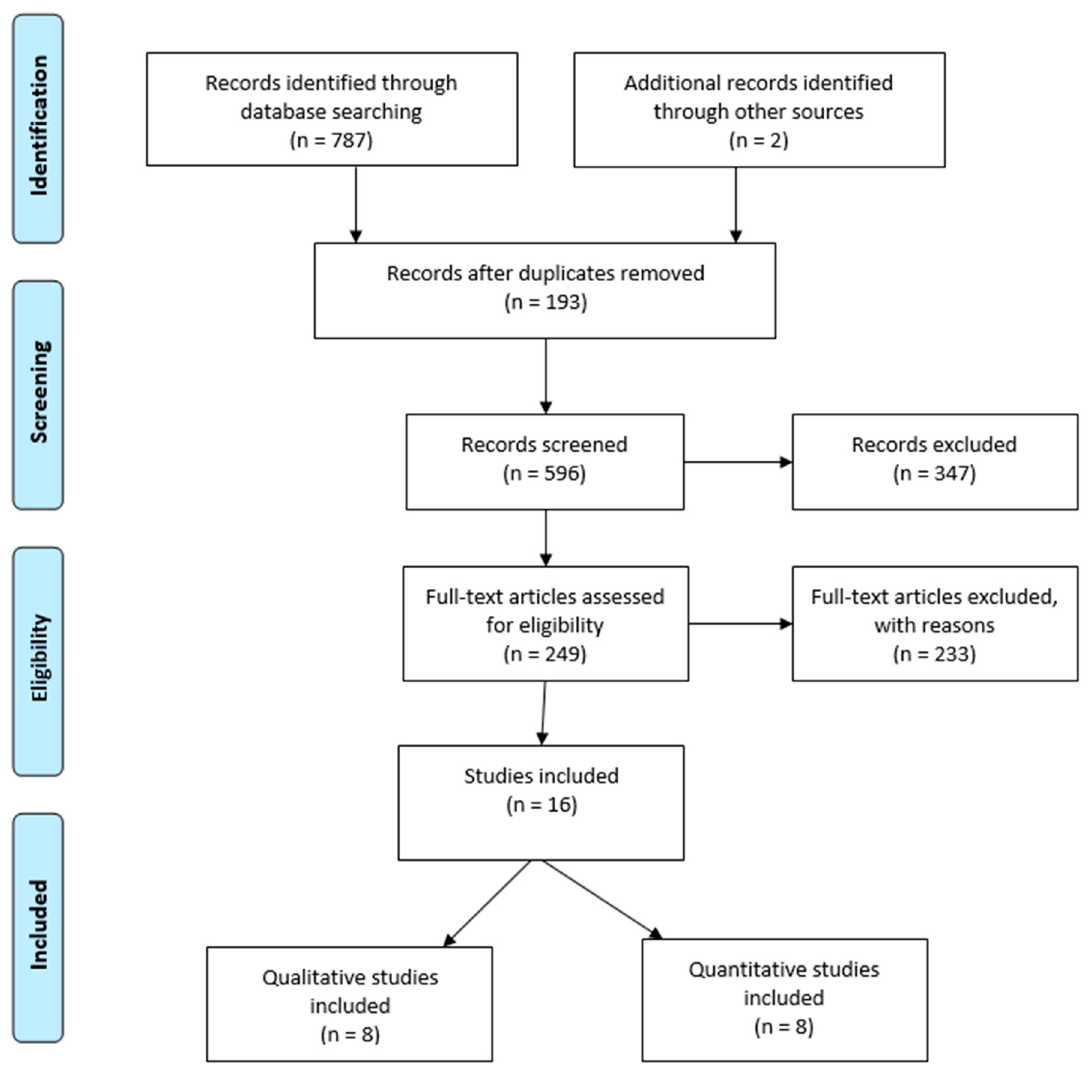
Figure 1. Preferred Reporting Items for Systematic Reviews and Meta-Analyses Extension for Scoping Reviews Checklist (PRISMA-ScR) flow diagram.